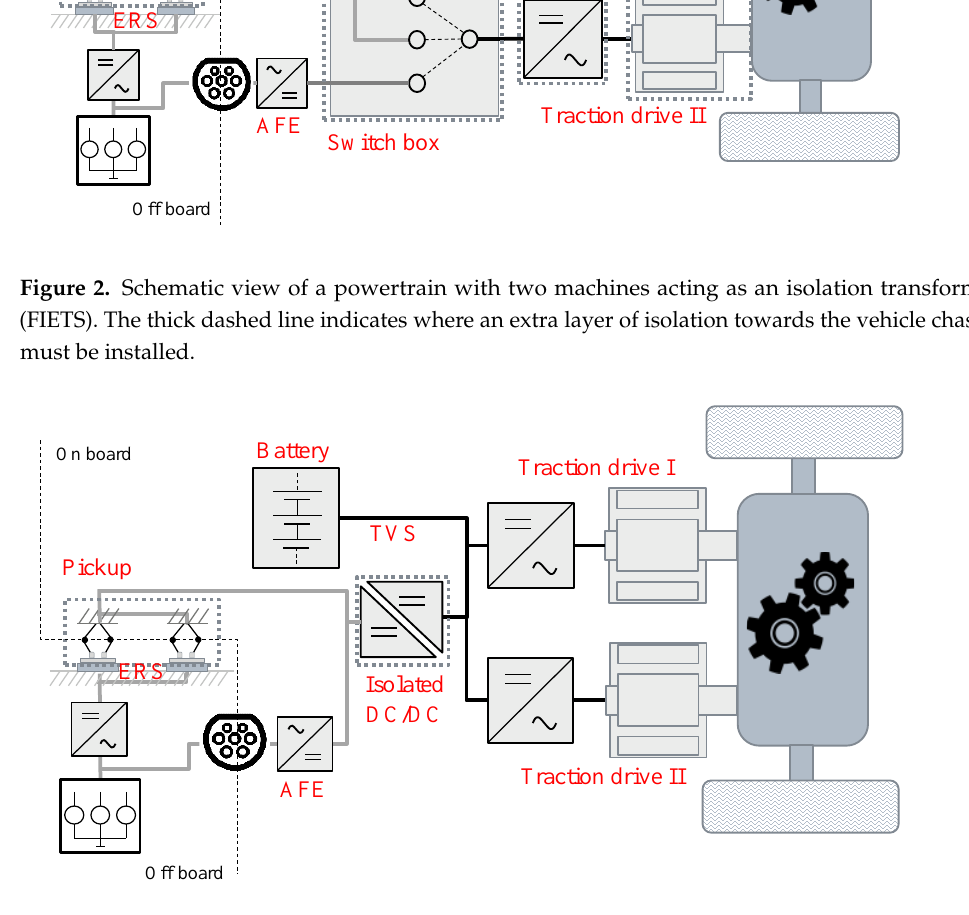
Figure 3. Schematic view of a powertrain a high-power, isolated, DC/DC converter (HSETS). The thick dashed line indicates where an extra layer of isolation towards the vehicle chassis must be